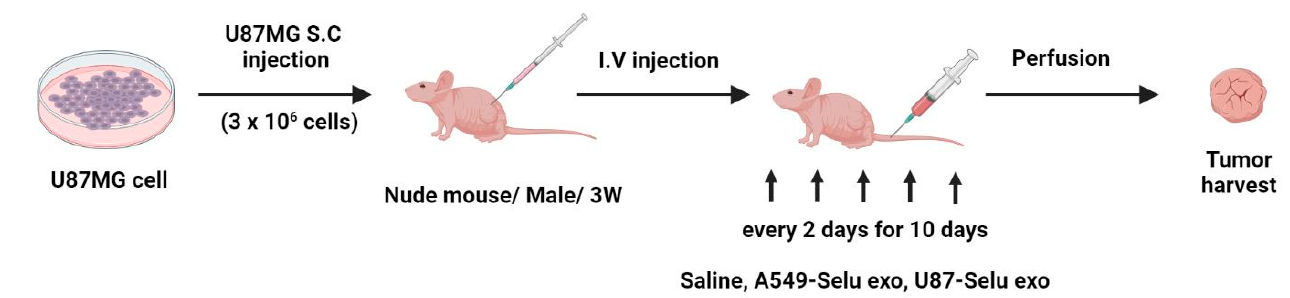
Figure 4. Overview of in vivo anticancer effect of U87-Selu exo and A549-Selu exo using a U87MG xenograft model.